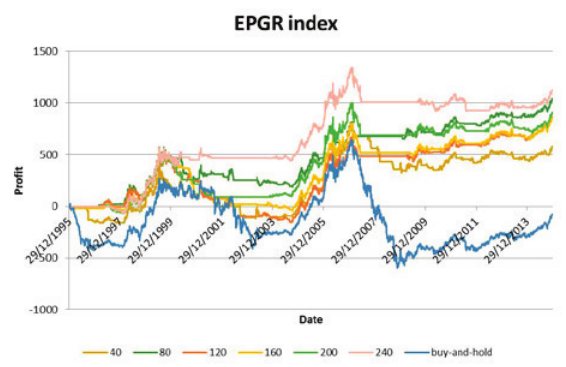
Figure 3. Profits of our strategy and “buy-and-hold” on UNUS index (without transaction costs)